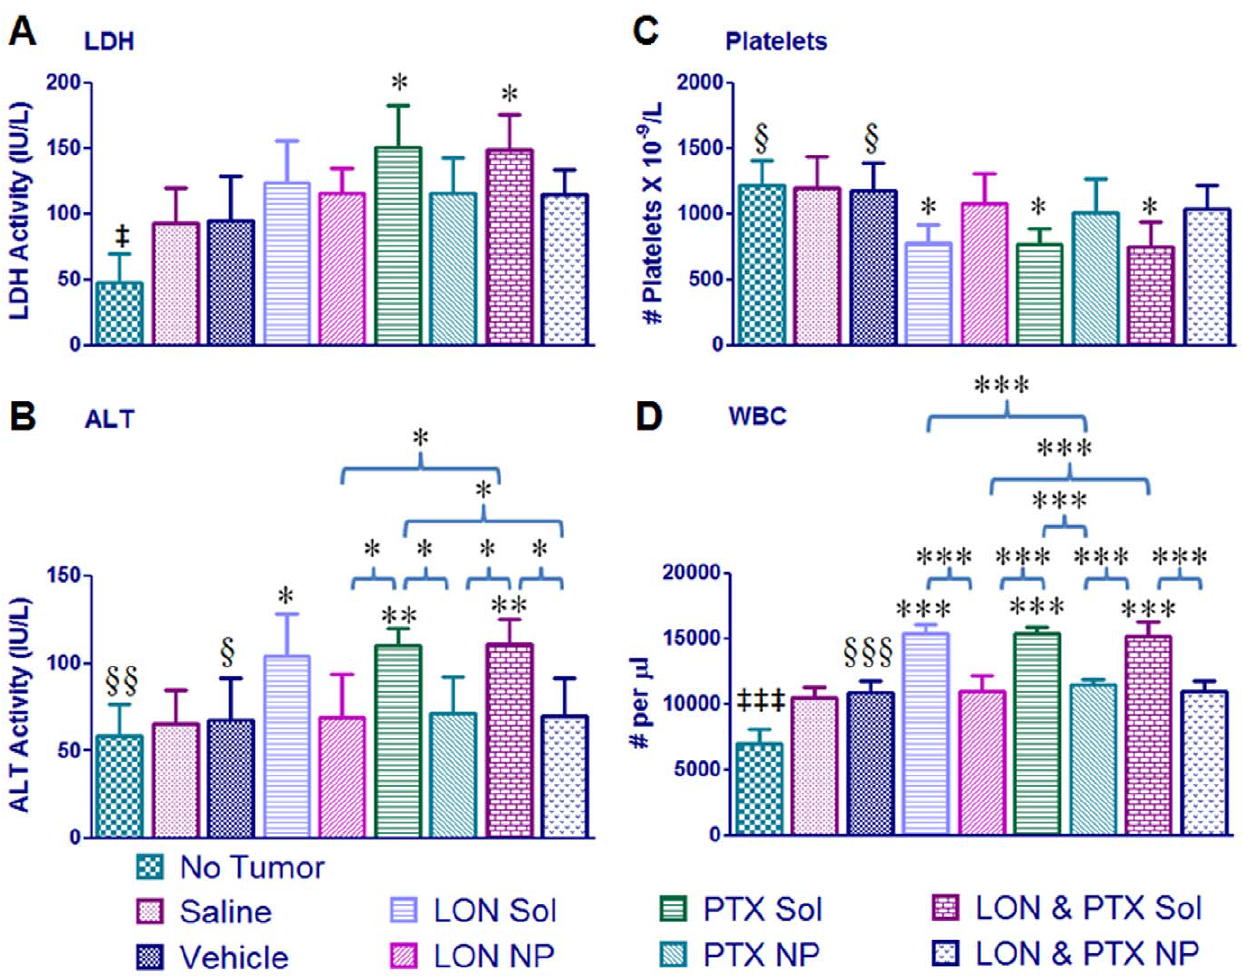
Figure 4. Toxicity analysis. Liver enzymes and blood counts were used to assess toxicity. For all graphs, each data point represents the mean 6 SD with an n =4. The double dagger represents significance between the No Tumor group and all other groups ( { p , 0.05, {{ p , 0.01, {{{ p , 0.0001). The section sign represents significance between the indicated group and all solution groups ( 1 p , 0.05, 11 p , 0.01, 111 p , 0.0001). The asterisks directly above the bars (no brackets) represents significance between that group and the saline group whereas asterisks above brackets indicate inter-group significance (* p , 0.05, ** p , 0.01, *** p , 0.0001). ( A ) Lactate dehydrogenase (LDH). ( B ) Alanine Aminotransferase (ALT). ( C ) Platelet Counts. ( D ) White Blood Cell (WBC) Counts.